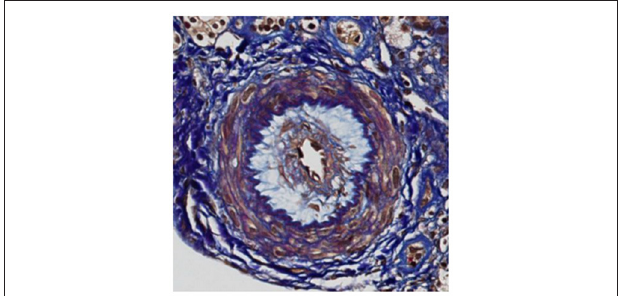
FIGURE 1 | Light microscopy. Early stage of thrombotic microangiopathy: this artery shows oedematous intima and few myointimal cells corresponding to “mucoid intimal hyperplasia” (FAOG, 400x).